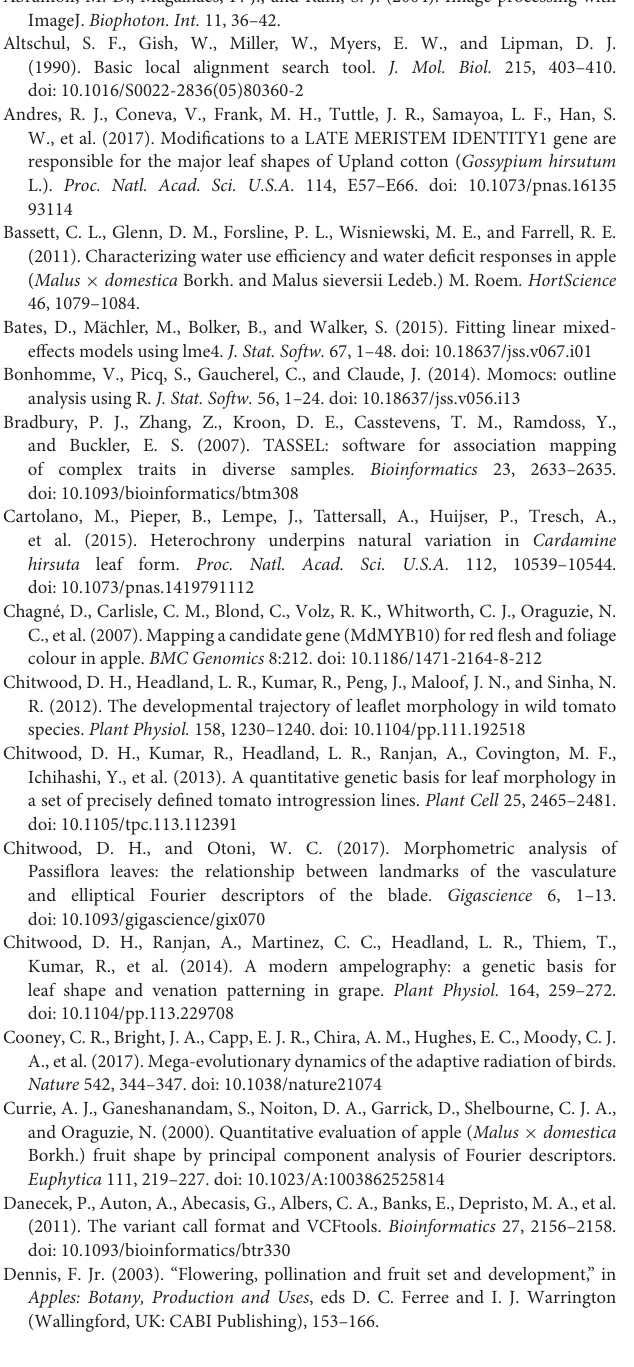
Table S7 | Genomic prediction accuracies (r) for leaf phenotypes. r_avg represents the average correlation between observed and predicted phenotype